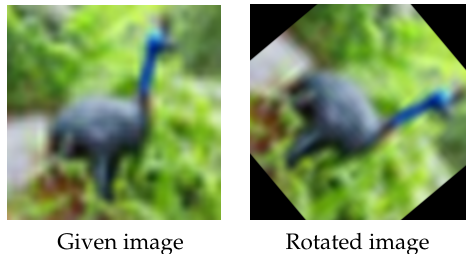
Figure 4. Traditional rotation. Left and right: the given image (from the CIFAR-10 dataset) and the rotated image with a randomly rotated angle. Black areas appear in the corners of the rotated image and the corners in the given image are cut off in the rotated image.